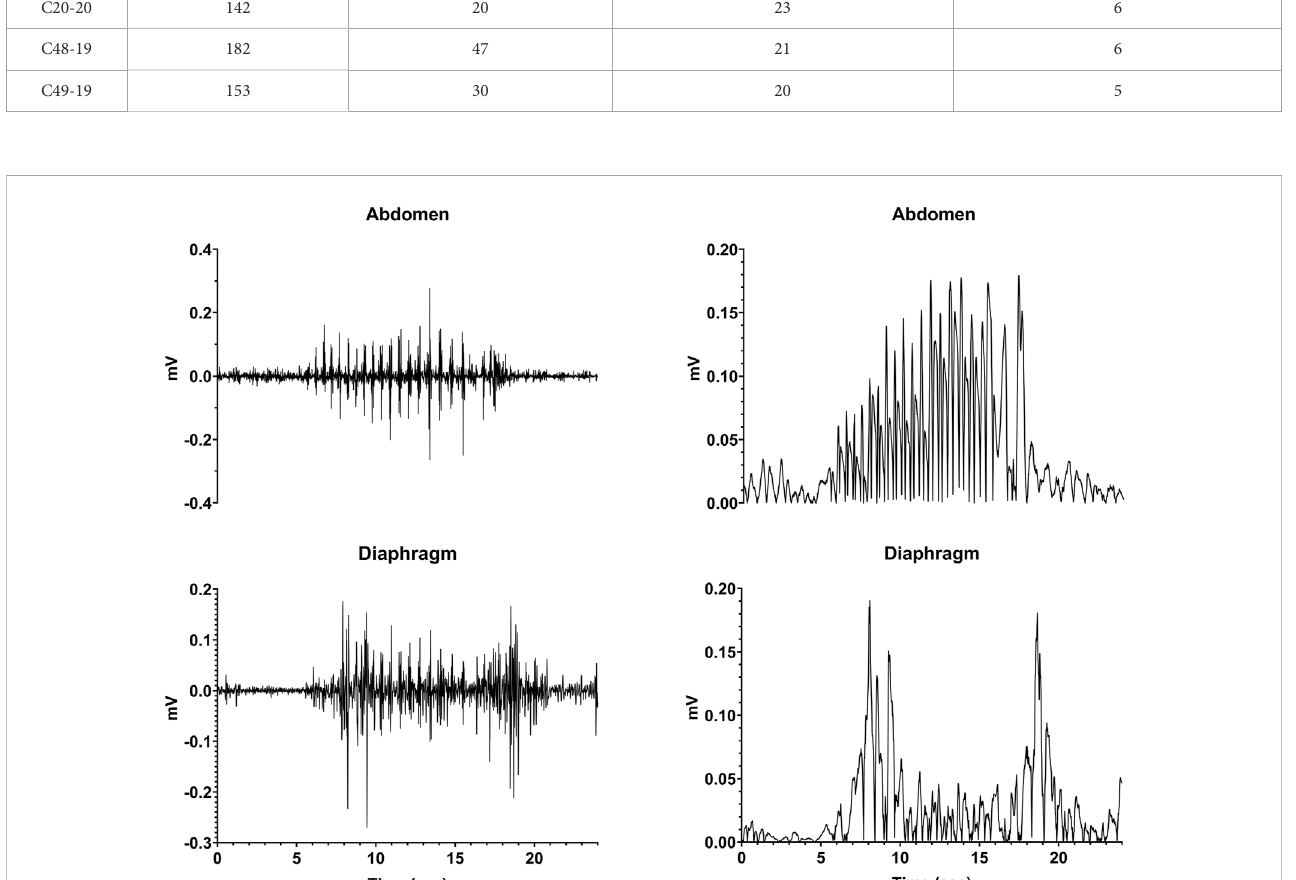
FIGURE 3 Recordings of diaphragm and abdominal muscle activity during a retching episode (continuous series of retches). The left traces are raw EMG activity, whereas the recordings are recti fi ed and smoothed (time constant of 0.2 s) in the right panels.